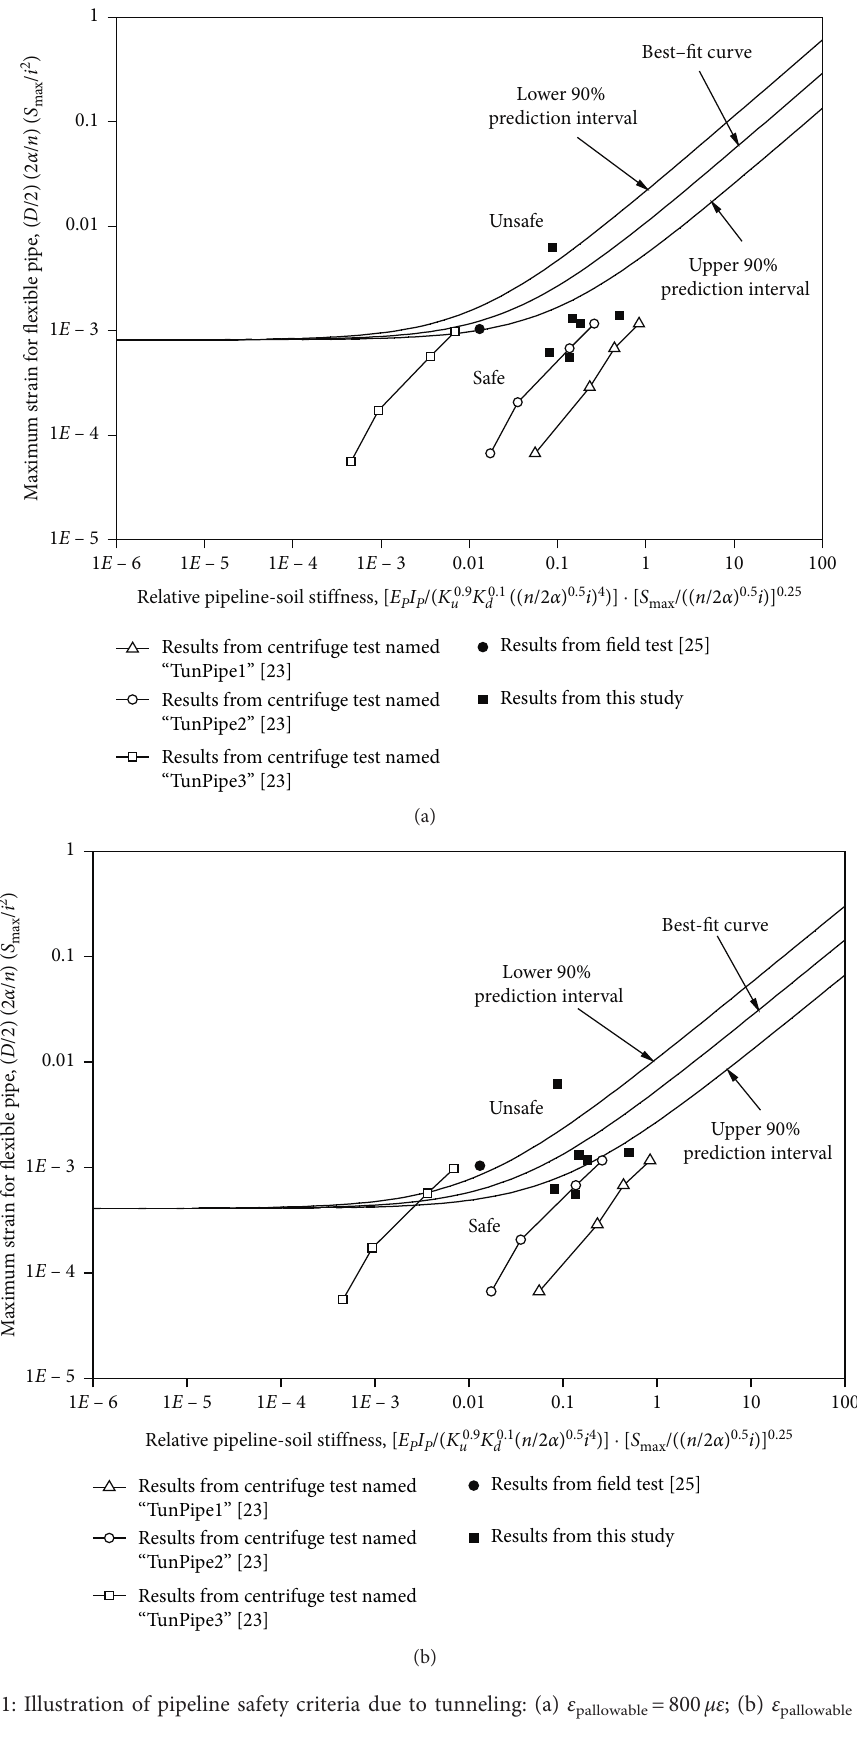
� 800 με ; (b) ε � 400 με pallowable pallowable